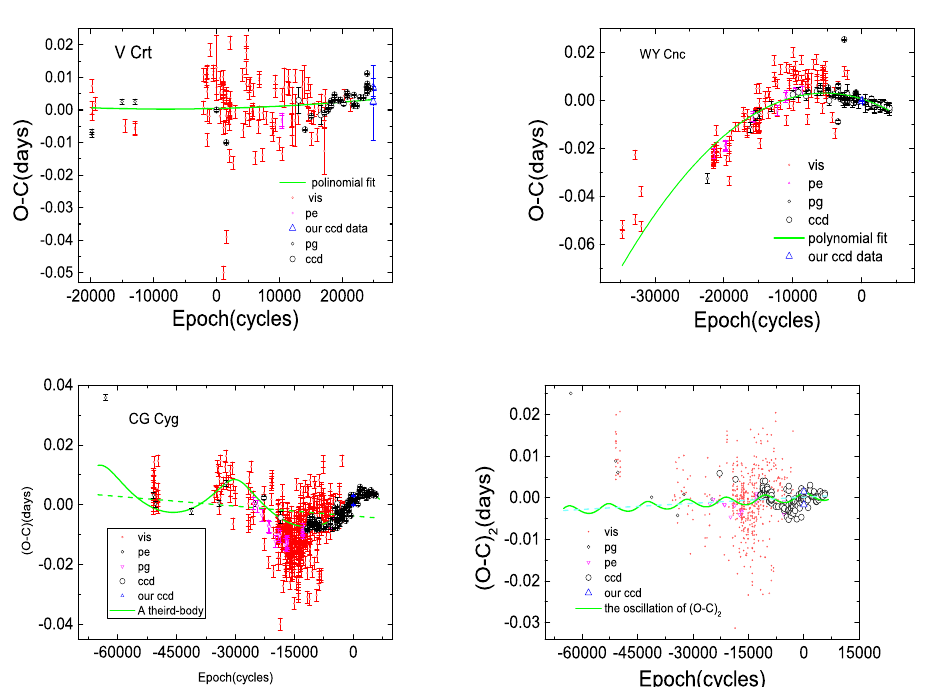
Figure 5. The fit of the minima times of eclipsing binaries, where the upper-left panel is the polynomial fit of V Crt, and the upper right panel is the polynomial fit of WY Cnc. The bottom left is the fit of third-body of CG Cyg, and the bottom right is the fit of (O-C) II of CG